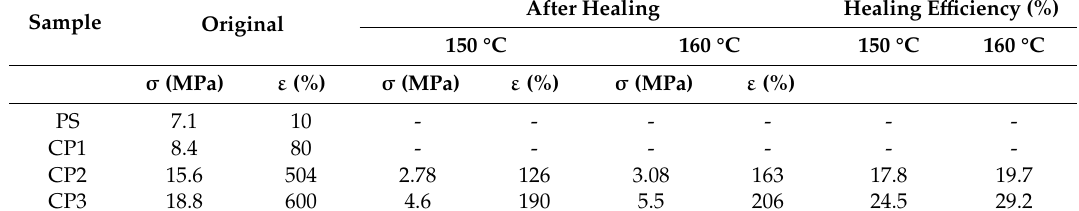
Figure 11. Stress-strain curves of the copolymers after healing at 150 ° C and 160 ° C for 24hr: ( a ) CP2; ( b ) CP3. Table 3. Self-healing properties of copolymers at different temperatures.